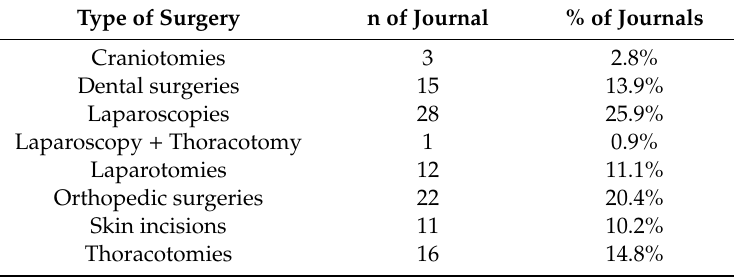
Table 3. Surgeries reported in the reviewed